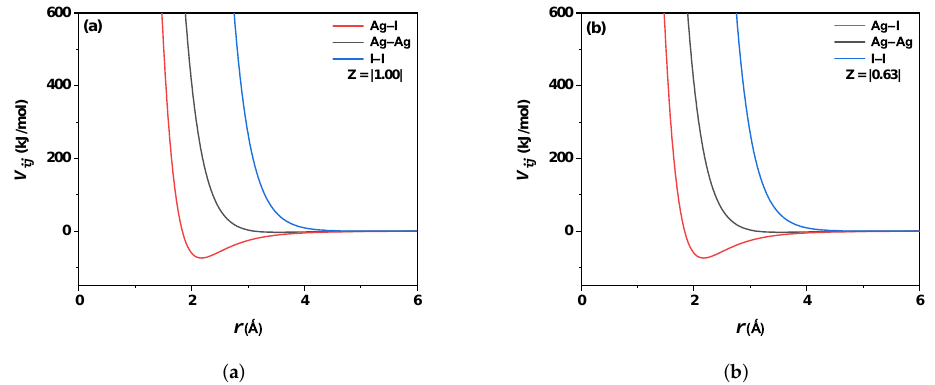
Figure 1. Behavior of the CB-type potential (1) for the three different interactions: Ag-I (solid red line), Ag-Ag (solid black line), and I-I (solid blue line). ( a ) for Z = | 1.00 | . ( b ) For Z = | 0.63 | .